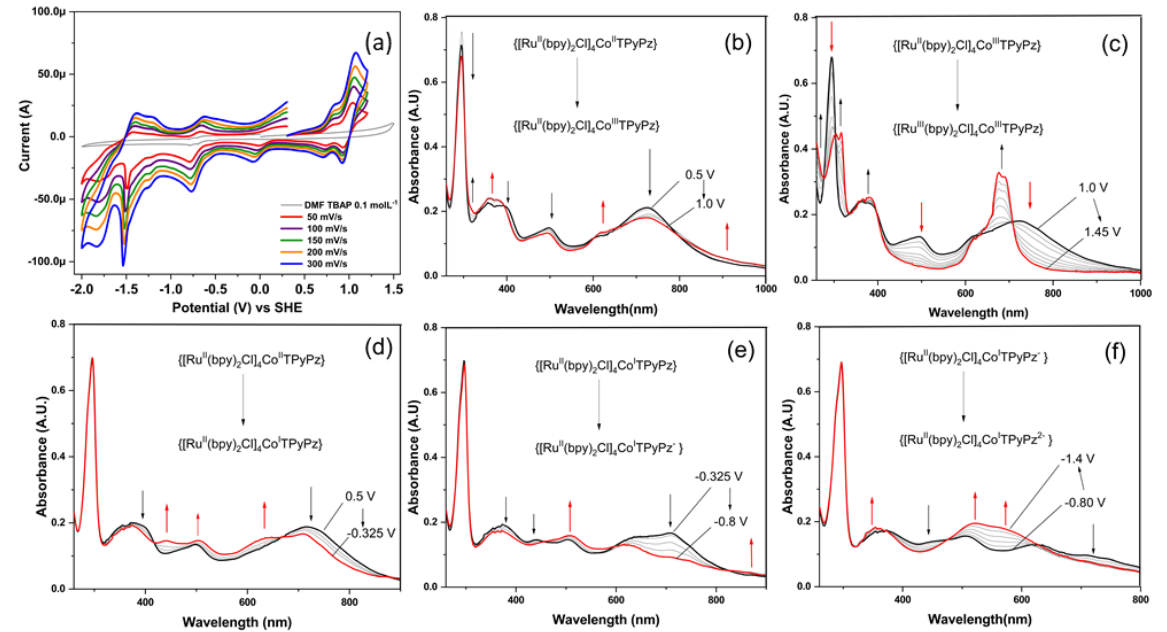
Figure 6. ( a ) Cyclic voltammogram of TRuCoTPyPz followed by ( b – f ) its spectroelectrochemistry at different potential ranges: ( b ) from 0.5 to 1.0 V; ( c ) from 1.0 to 1.45 V; ( d ) from 0.5 to − 0.325 V; ( e ) from − 0.325 to − 0.8 V; ( f ) from − 0.8 to − 1.4 V. Spectroelectrochemical results were recorded shifting the potential in steps of 25 mV.